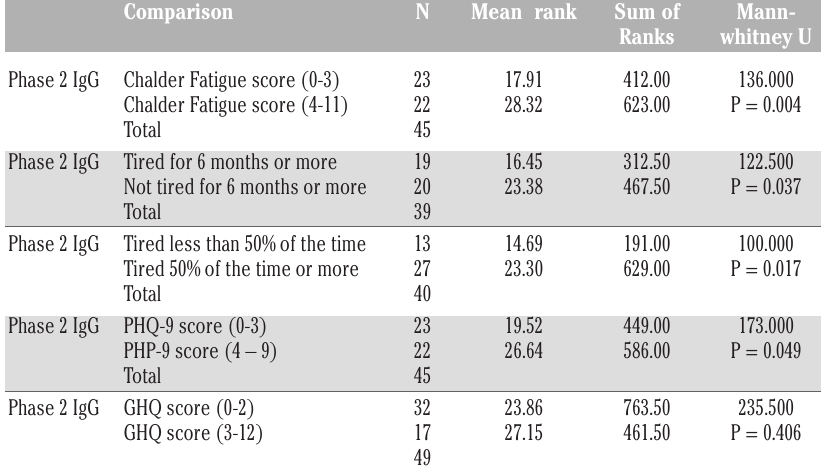
Table 3. Relationship between Phase 2 IgG in 2008 and symptoms measured at the same